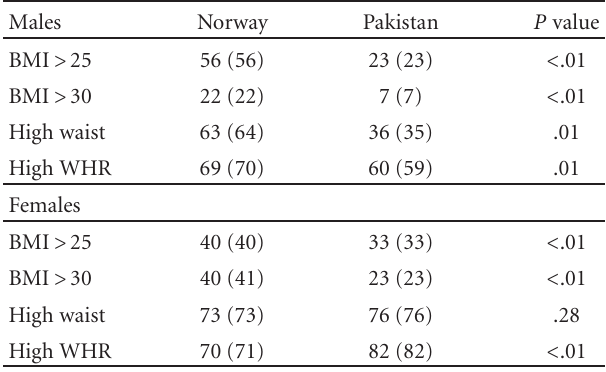
Table 2: Prevalence of obesity (per 100) among Pakistanis and Pakistanis residing in Oslo. Age adjusted values in brackets. Males Norway